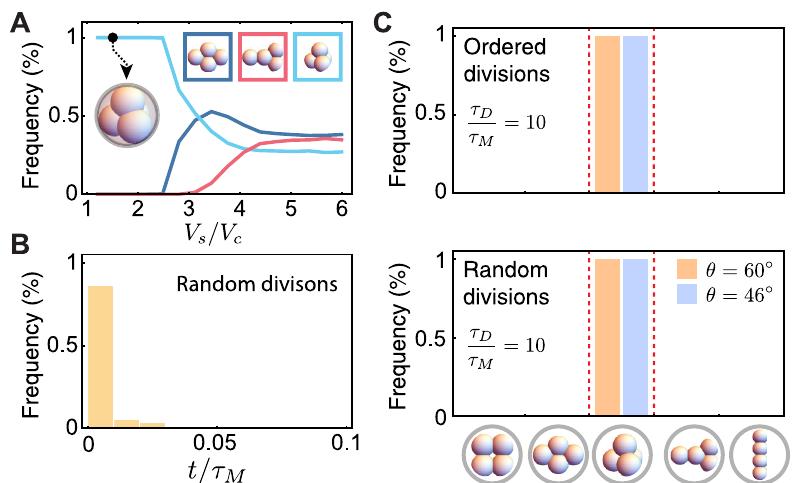
Fig 3. Spherically confined cellular packings. A , Frequency of different cell arrangements for embryos with spherical repulsive confinement as the ratio of the shell volume and total cells volume varies (random divisions; τ D / τ M = 10; n = 10 4 simulation runs for each parameter set). B , Histogram of the time to reach the equilibrium tetrahedral configuration (n = 10 3 simulation runs). C , Frequency of packing arrangements for embryos confined in a spherical repulsive shell ( a / b = 1; V / V = 1.52), and both slow and fast divisions ( τ / τ = 0.1, 10, respectively), different contact s c D M angles θ and both ordered and random division rules (n = 500 simulation runs for each parameter